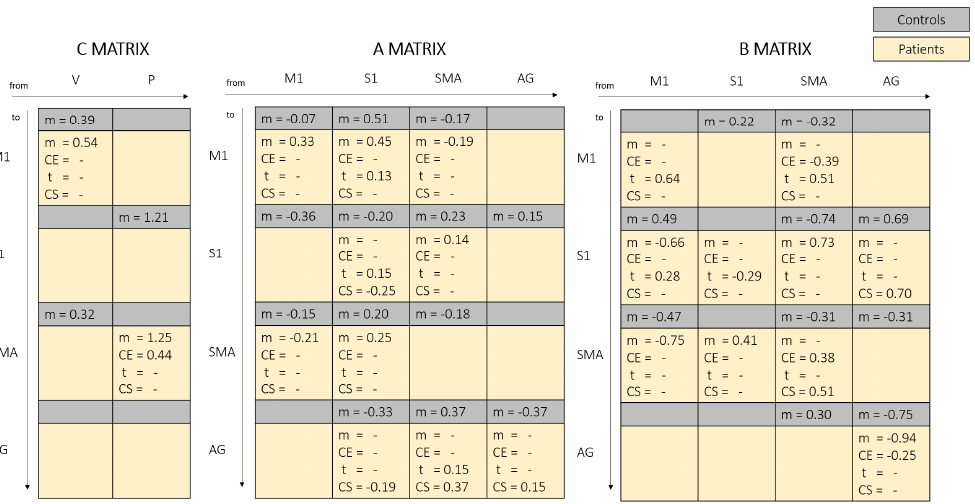
Figure 3. Healthy controls and patients Dynamic Causal Modelling (DCM) estimates in matrix representation. V: voluntary input; P: proprioceptive input; M1: primary motor cortex; S1: primary sensorimotr cortex; SMA: supplementary motor area; AG: angular gyrus; m: mean component; CE: carryover effect regressor; t: time regressor; CS: capacity score regressor.